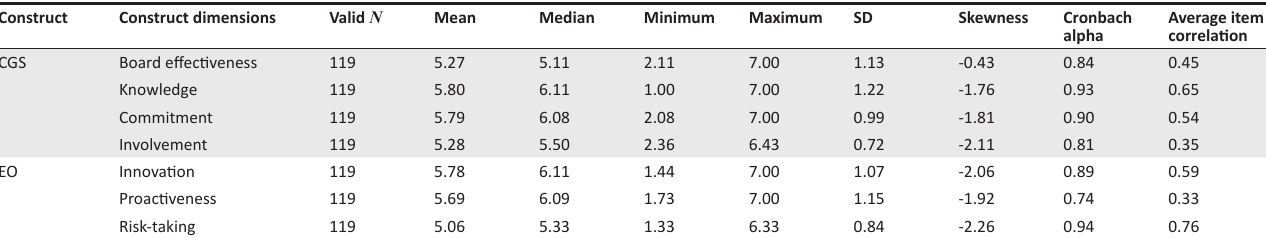
TABLE 3: Descriptives for corporate governance systems and entrepreneurial orientation scales.